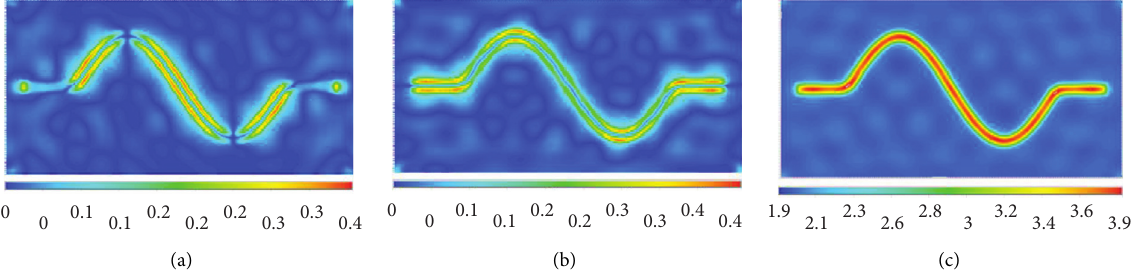
u u x , (b) y , and (c) z